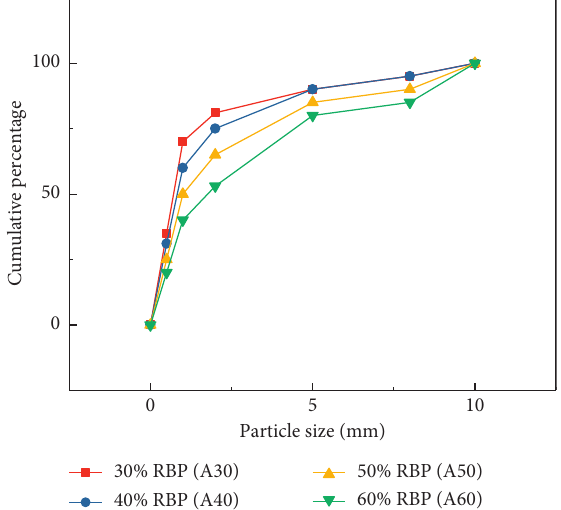
Figure 4: Particle gradation of soil-rock